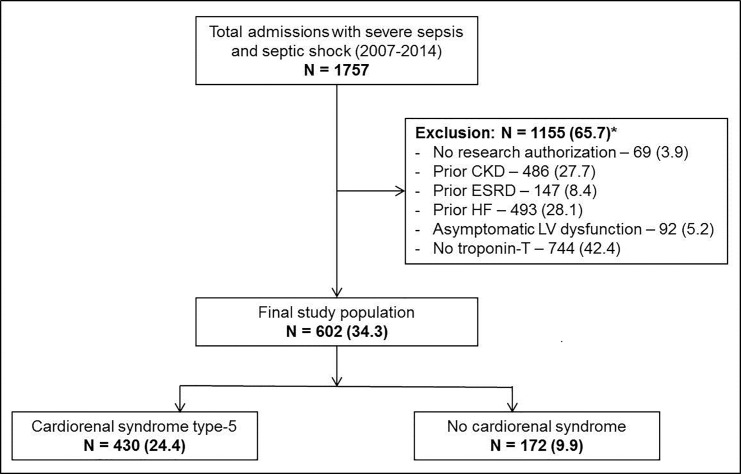
Study population.*Individual percentages are not additive due to multiplicity of exclusion criteria Represented as: Number (Percentage) Abbreviations: CKD: chronic kidney disease; ESRD: end-stage renal disease; HF: heart failure; LV: left ventricular.